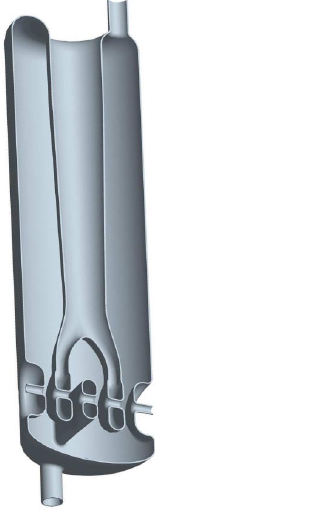
of the cavity is shown.FIG. 8. (Color) PROE model of the type-II 4